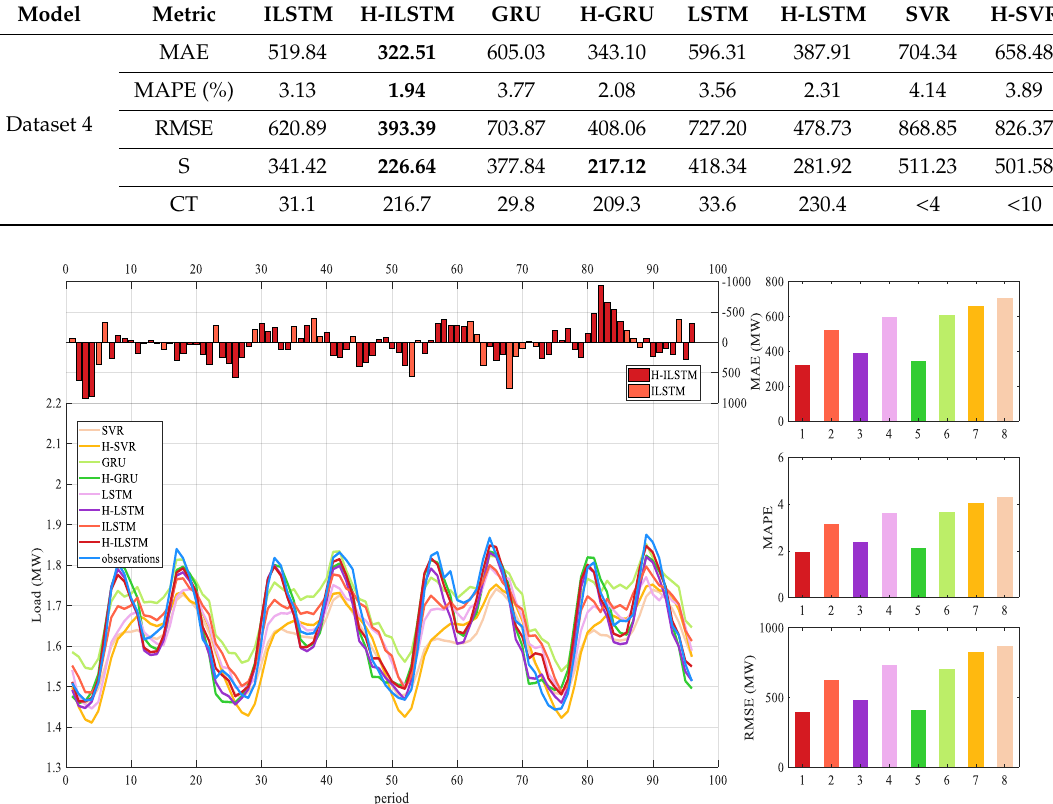
Figure 14. Forecasting performance of eight models for dataset 4.